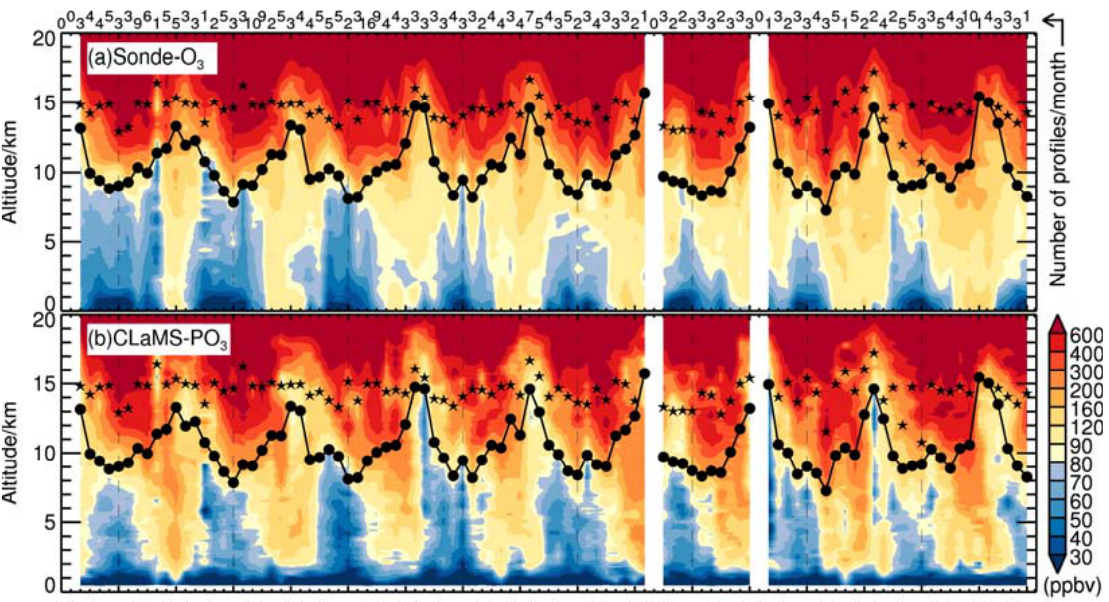
Fig. 1. Monthly mean ozone profiles from (a) ozonesonde observation and (b) CLaMS-PO 3 (passively transported ozone) from the CLaMS simulation at the time and location of the measurement, during 2002–2010 in Beijing. The first (LRT1) and second (LRT2) thermal tropopauses are shown as a thick line with solid dots and stars respectively. There were no observations available during September 2007 and August 2008.